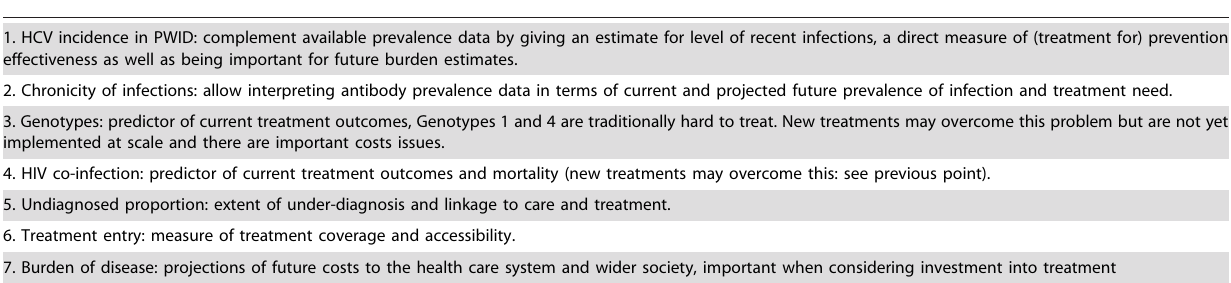
Table 1. Data items reviewed and their rationale for HCV